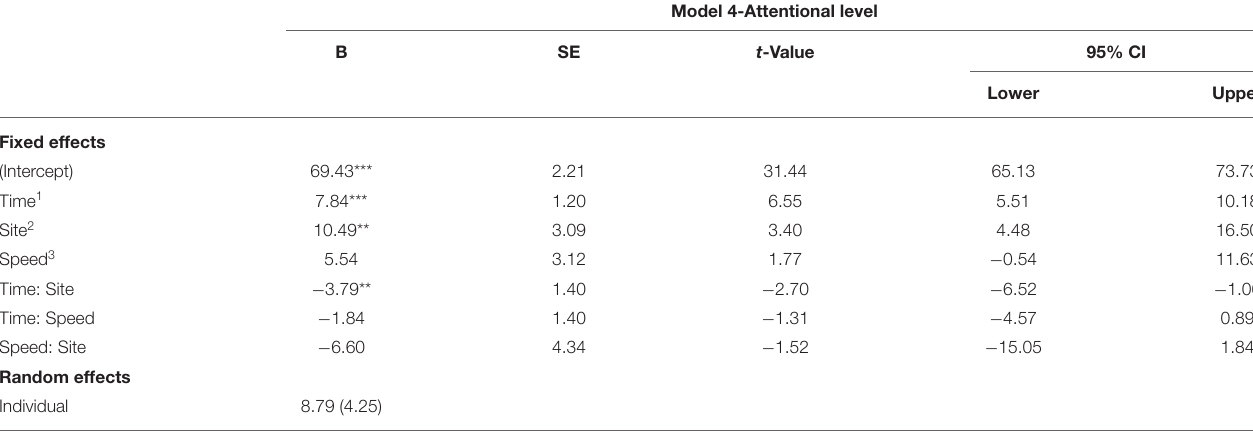
TABLE 3 | Multilevel modeling results for the effects of walking conditions on the attentional level.